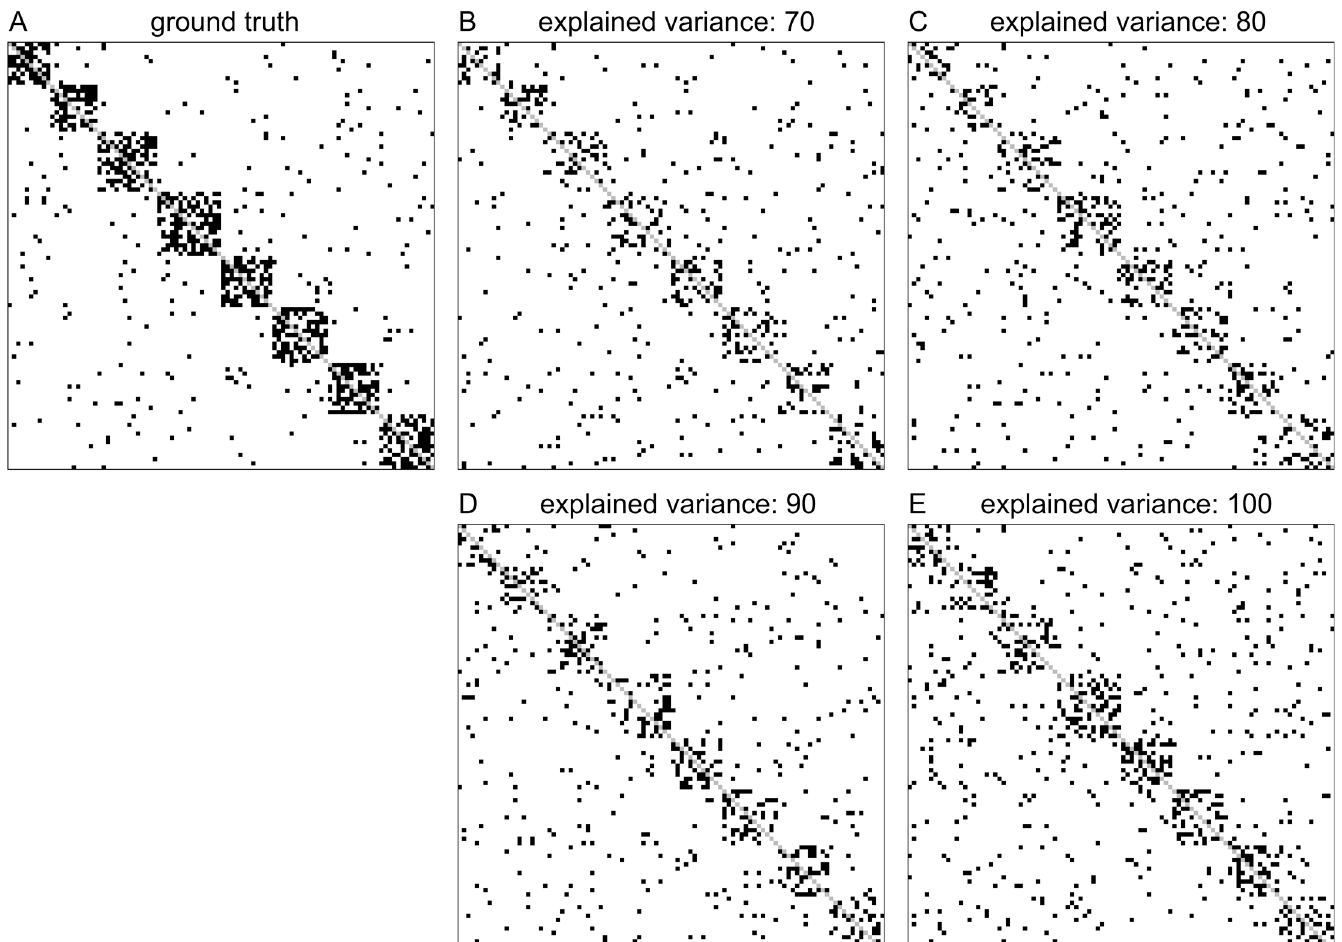
Fig 5. Plots of example adjacency matrices of the ground truth network and corresponding lsGCI networks with different degrees of dimension reduction ( D = 100, N = 1000). (A) ground truth network; (B-D) lsGCI network with variance explanations from 70%-90%; (E) GCI network.